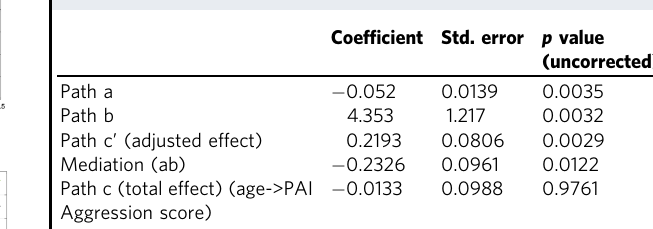
Table 3 Statistics for mediation analysis between age and PAI Aggression score with GSP feature from right isthmus cingulate as mediator variable for HC